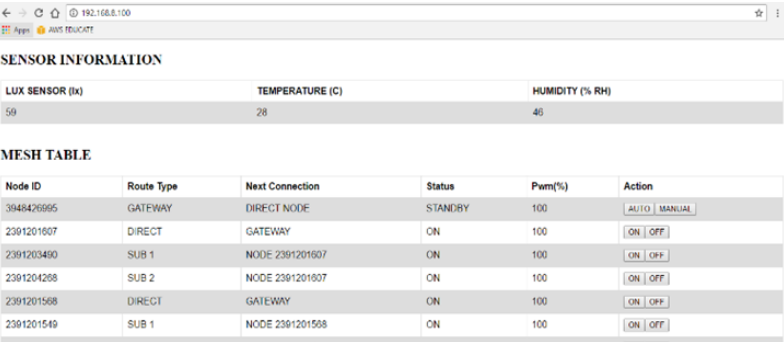
Fig. 4. Interface of web server (50 Lux, 28oC, and